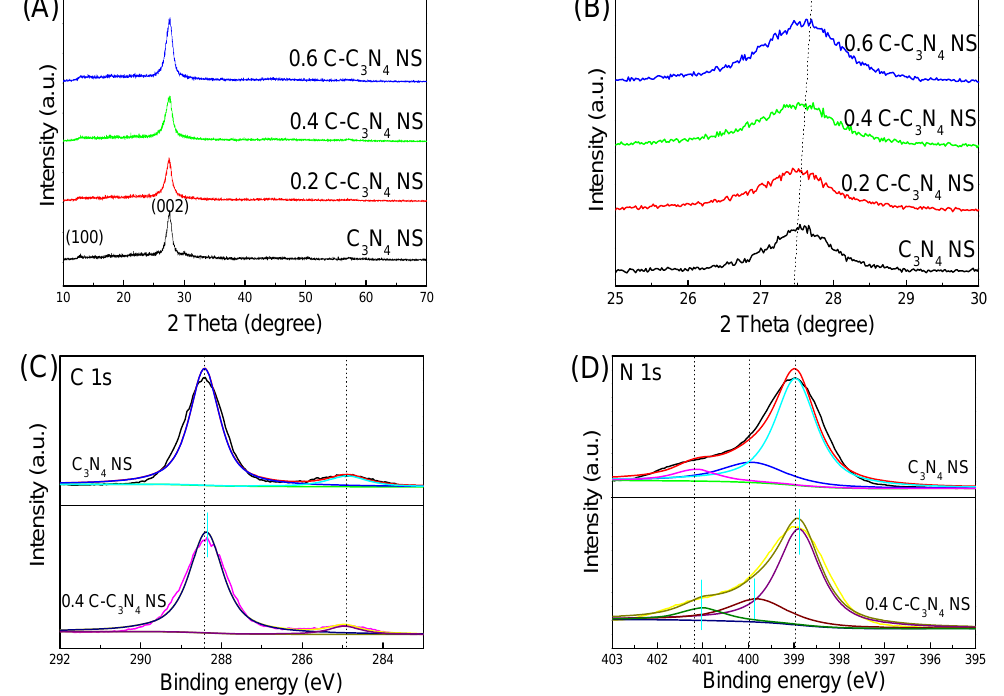
Figure 4. ( A ) XRD patterns and ( B ) enlarged XRD patterns of series samples. High ‐ resolution XPS spectra of ( C ) C 1 s and ( D ) N 1 s of C 3 N 4 NS and 0.4 C ‐ C 3 N 4 NS.